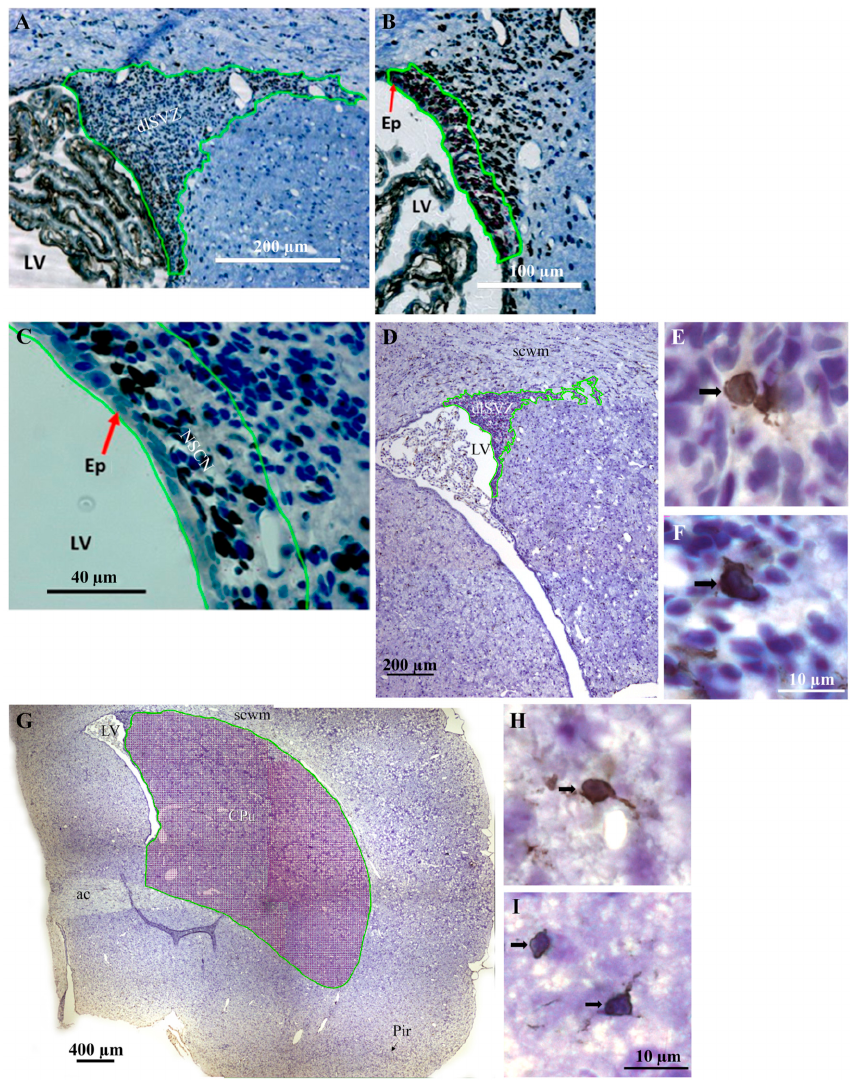
Figure 5. Representative brightfield images of the dorsolateral subventricular zone (dlSVZ), the neural stem cell niche (NSCN) region of the dlSVZ, and the caudate-putamen (CPu), including immunostained cells (e.g., microglia). ( A ) shows the inferomedial boundary of the dlSVZ, and ( B , C ) illustrate the NSCN region of the dlSVZ, in a postnatal day (PN) 17 rat pup exposed to hypoxia-ischemia (HI) on PN7. ( B ) is shown at a higher magnification in ( C ). Note in ( C ) that the NSCN region is ~4 cell diameters adjacent to the ependymal (Ep) cell lining of the lateral ventricle (LV). Bromodeoxyurdine-positive cells are stained black due to immunostaining using diaminobenzidine. Other cells and tissues are stained blue due to counterstaining with thionin. ( D , G ) Outline of the dlSVZ ( D ) and CPu ( G ) in a posterior coronal section from the brain immunostained with the microglial marker, anti-ionized calcium-binding adaptor protein 1 (IBA-1), and counterstained with thionin (blue). The section is from a PN17 rat pup that was exposed to HI at PN7 and treated with cultured adipose-derived-mesenchymal stem cells (AD-MSCs) on PN14 and PN16. ( E , F ) An image of an IBA-1 positive microglial cell in the dlSVZ of a HI AD-MSCs × 2 (double)-treated ( E ) and HI diluent-treated ( F ) rat pup. ( H , I ) An image of an IBA-1 positive microglial cell in the CPu of a HI AD-MSCs × 2-treated ( H ) and HI diluent-treated ( I ) rat pup. Black arrows indicate microglial cells, which had a pale nucleus that was surrounded by an IBA-1-positive dark brown/black circumferential, or almost circumferential, soma as a result of immunostaining using diaminobenzidine. ac, anterior commissure; cc, corpus callosum; Pir, piriform cortex; scwm, subcortical white